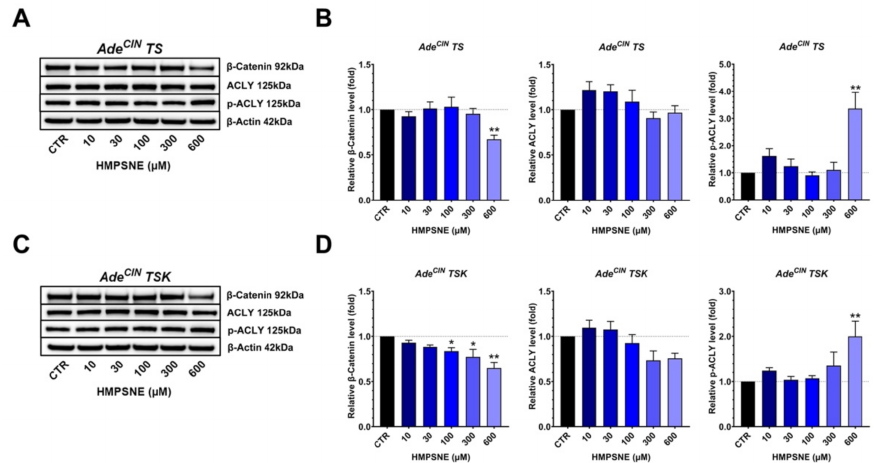
Figure 7. Effect of pharmacological inhibition of 3-MST on the induction of the Wnt/ β -catenin pathway in Ade CIN TS and Ade CIN TSK organoids . ( A , B ) Western blot analysis of β -catenin, ACLY and p-ACLY in Ade CIN TS organoids in the presence of increasing concentrations of HMPSNE for 48 h. ( C , D ) Western blot analysis of β -catenin, ACLY and p-ACLY in Ade CIN TSK organoids in the presence of increasing concentrations of HMPSNE for 48 h. Data represent mean ± SEM of at least 4 independent experiments. * p < 0.05, ** p < 0.01 compared to